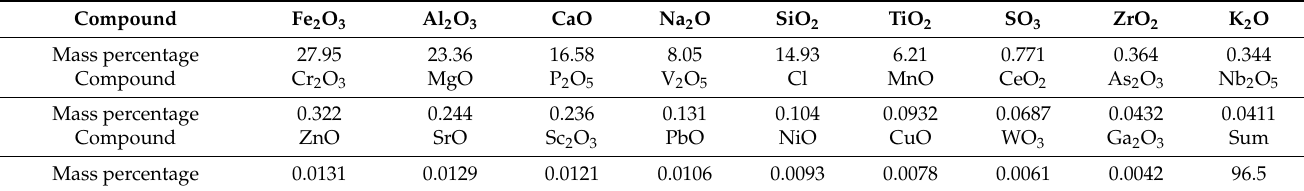
Table 1. The main components of the red